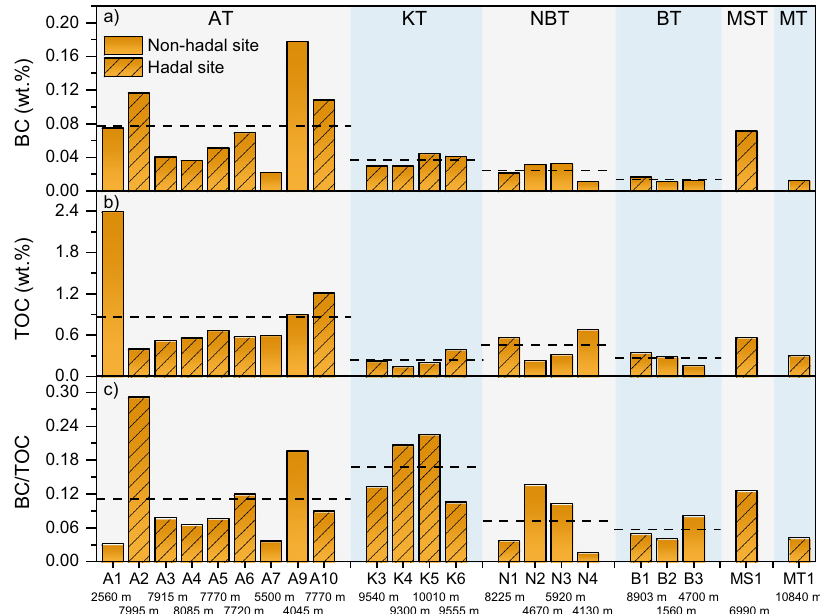
Fig. 3 Summary results of black carbon (BC) content, total organic carbon (TOC) content, and BC/TOC ratio in surface sediments from six trench regions. a BC content. b TOC content. c BC/TOC ratio. AT Atacama Trench, BT Bougainville Trench, KT Kermadec Trench, MST Mussau Trench, MT Mariana Trench, NBT New Britain Trench. The dash lines denote average values of the parameters in each trench.